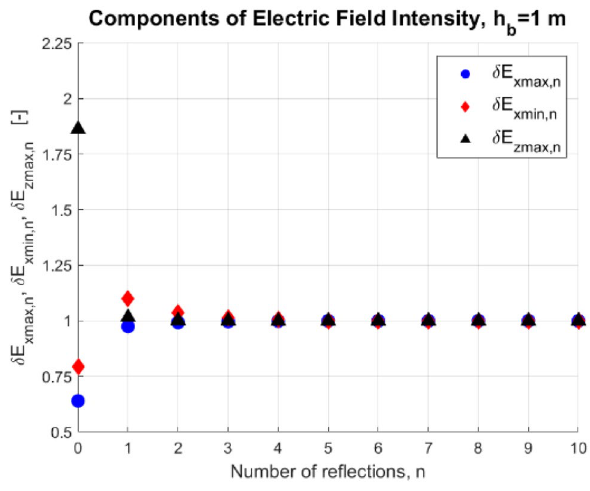
Figure 6. Dimensionless components of electric field intensity ( h w = 10 m, h b = 1 m, z = − 9 m, n —number of